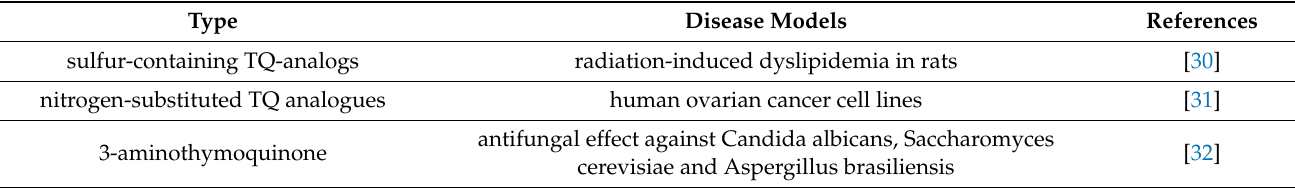
Table 1. Some analogs have been developed for enhanced bioavailability and activity of TQ.